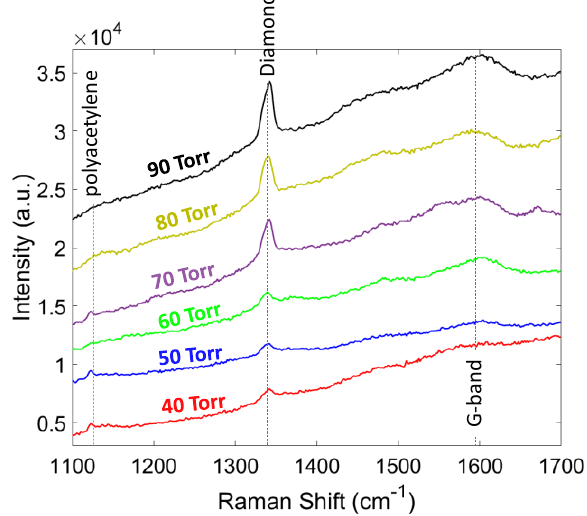
Figure 7. Raman spectra of the diamond films grown at different pressures. Table 2. Grain size, thickness, Raman peak, phase purity, and stress of diamond at different pressures. Pressure (Torr)